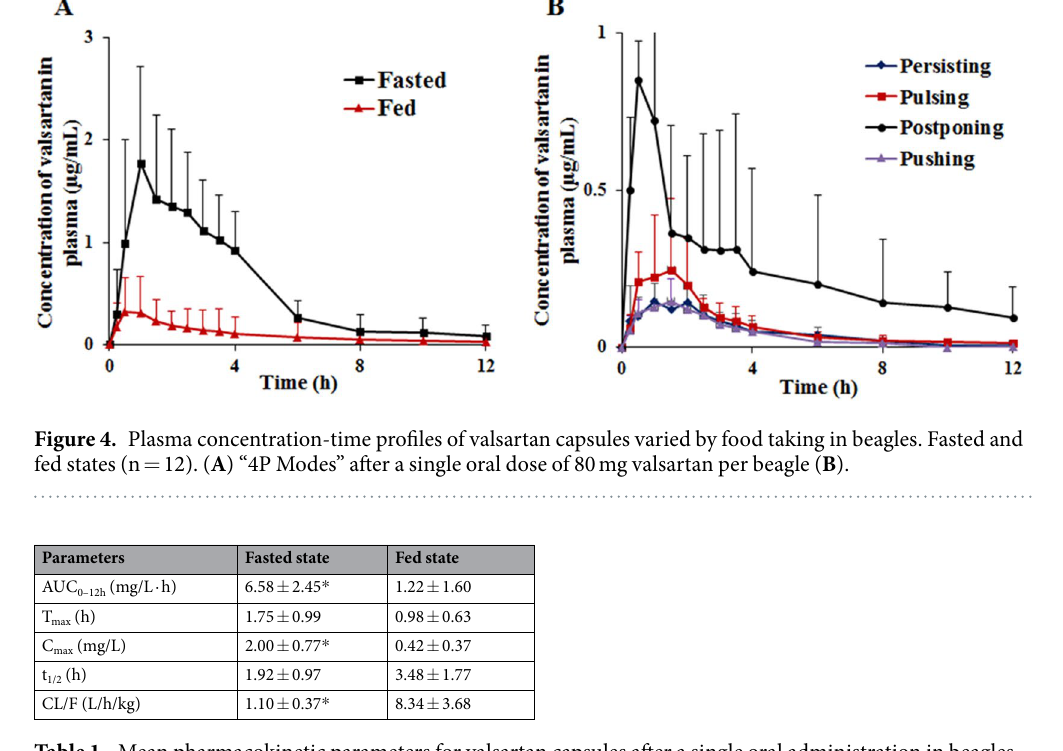
Table 1. Mean pharmacokinetic parameters for valsartan capsules after a single oral administration in beagles of 80 mg valsartan per beagle (n = 12). Data were reported as mean ± SD. Comparison between groups was done by t-test. * p < 0.05, compared with fed state.